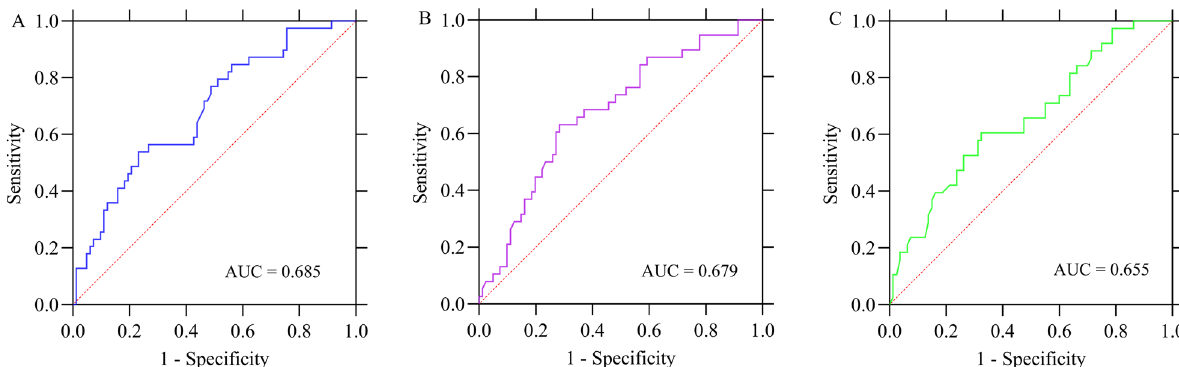
Fig. 2 In male patients with NSCLC, the area under the receiver operating characteristic curve (AUC) for individual factors was calculated to predict EGFR mutation status. A SUV max of the primary lesions. B Serum concentration of CYFRA21-1. C Serum concentration of